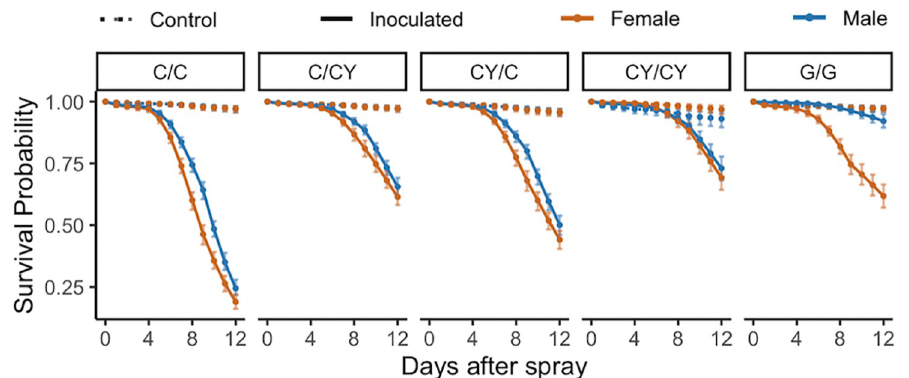
Fig 5. Yeast supplementation affects sexual dimorphism in survival of D . melanogaster inoculated with B . bassiana strain GHA (Experiment 4). Three days prior to control spray (dashed lines) or fungal spray (solid lines), flies were given cornmeal (C), cornmeal with yeast supplement (CY), or glucose (G) diets (marked before the dash in